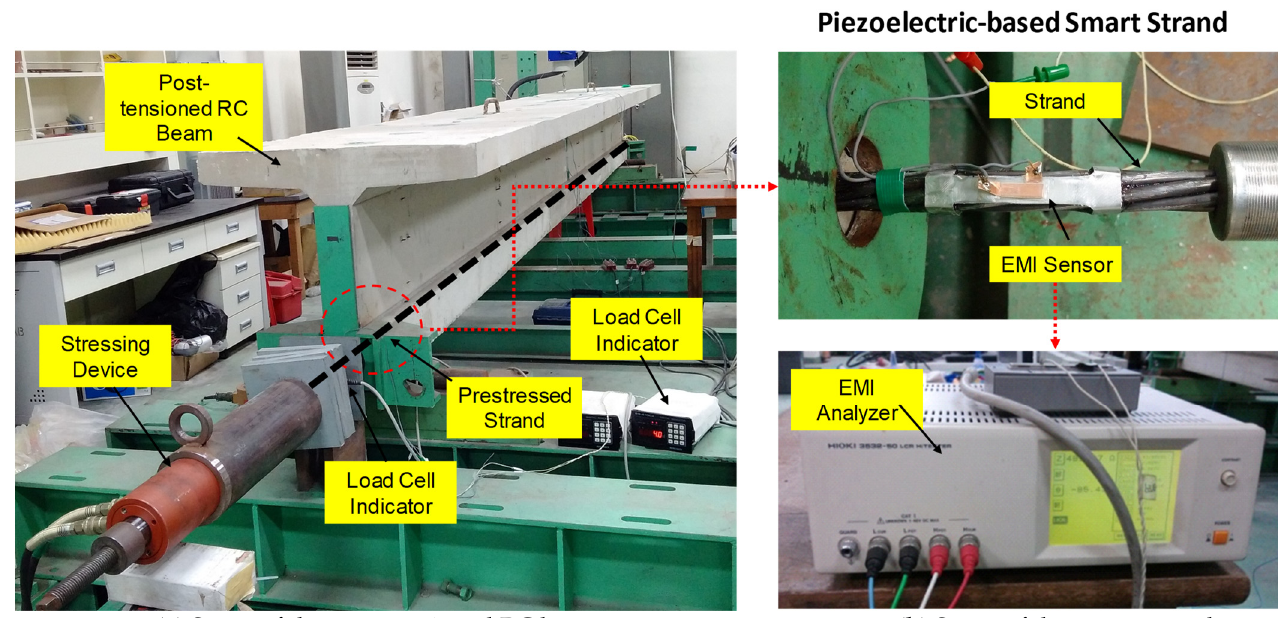
Figure 5. Experimental setup.